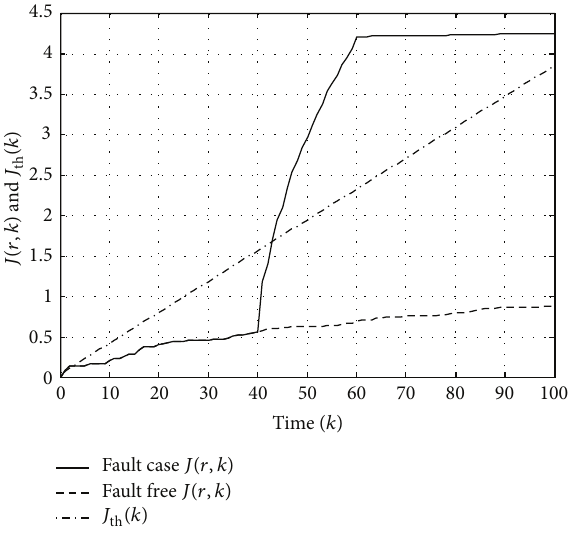
Figure 2: Residual evaluation function 𝐽(𝑟, 𝑘) and threshold 𝐽 when 𝜌 = 1 and 𝐷 𝑓 (𝑘) = 1.8